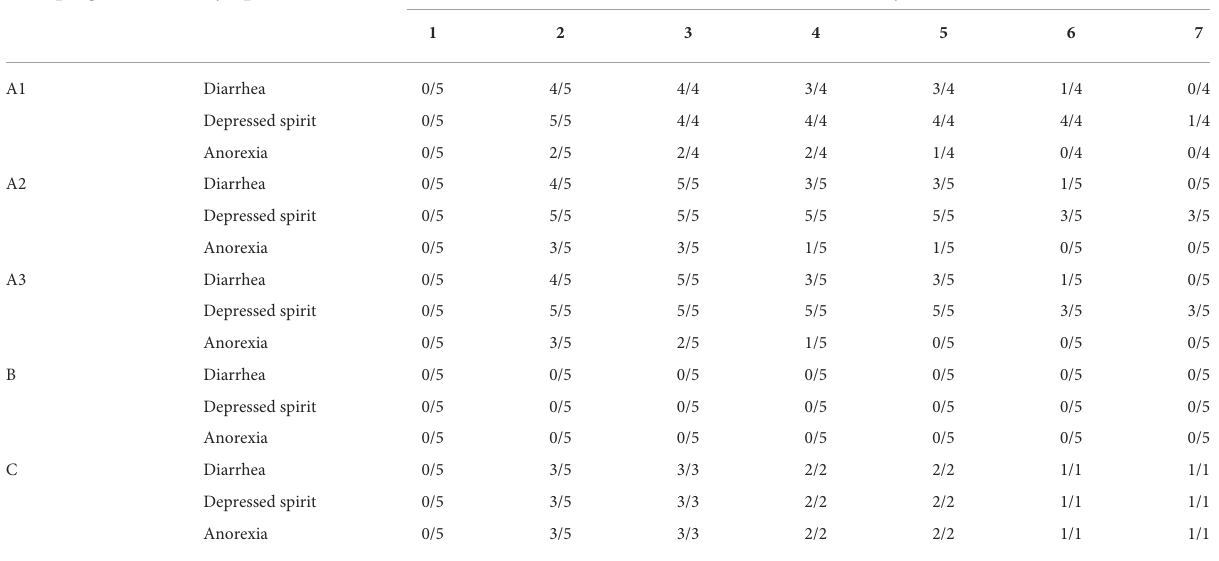
TABLE 3 Statistics of clinical symptoms in each group after the attack. Grouping